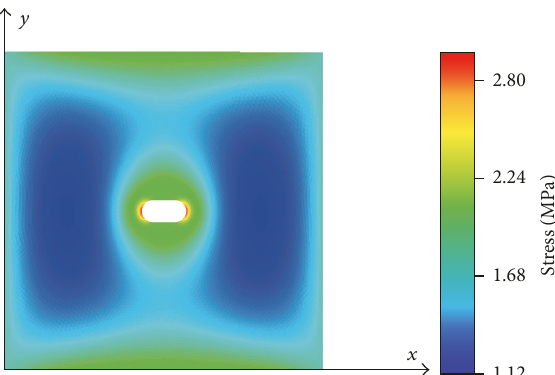
Figure 12: The distribution of the stress 𝜎 11 for the square polyurethane foam plate 10.0 m × 10.0 m × 1.0 m demonstrates the stress concentration around the hole (160,000 elements used).